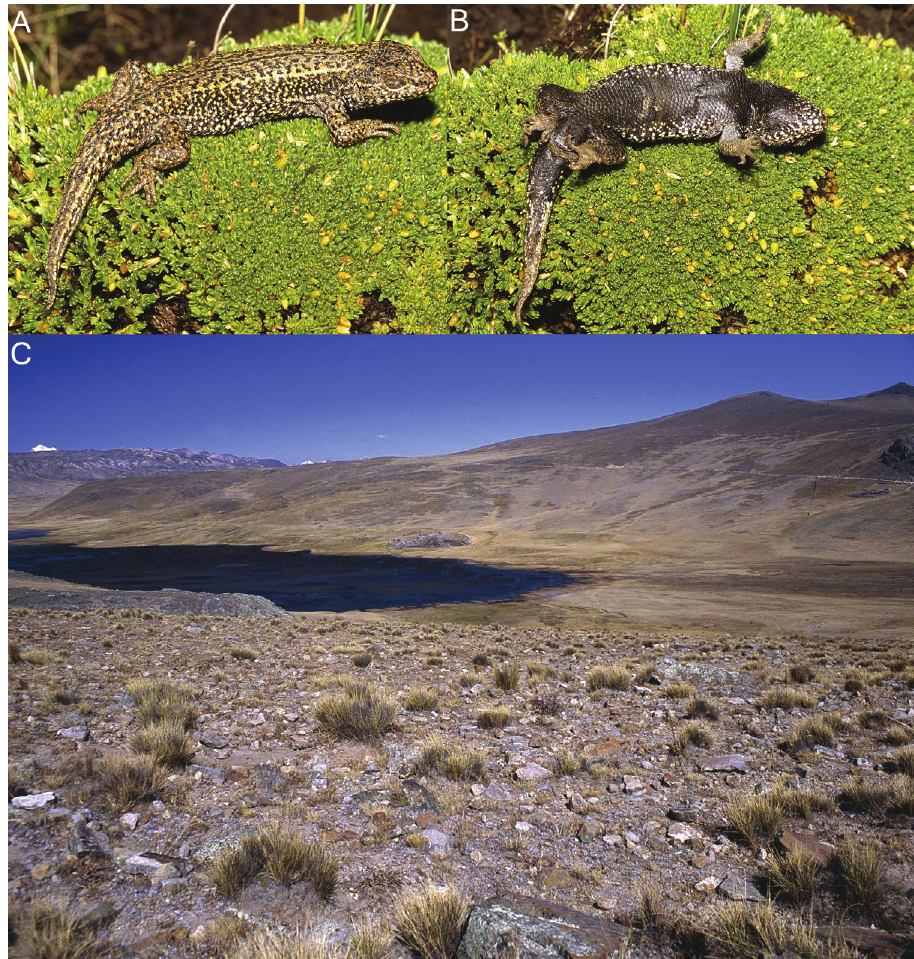
Figure 8. Dorsal ( a ) and ventral ( B ) views of the holotype of Liolaemus chavin sp. n. ( C ) Type with rostral, separated from first supralabial by one scale, nasal bordered by eight scales; canthus separated from nasal by one scale. Six supralabials. Six lorilabial scales, three in contact with the subocular. Six infralabials. Auditory meatus oval (height 2.3 mm, width 1.2 mm), with three small, projecting scales on anterior margin. Seven convex, smooth temporals. Orbit–auditory meatus distance 4.9 mm. Orbit–anterior margin of rostral distance 6.3 mm. Rostral almost three times wider than high (width 2.9 mm; height 1.2 mm). Mental subpentagonal, about two times as wide as high (width 3.2 mm; height 1.7 mm). Interparietal pentagonal with an elongated posterior apex, bordered by eight scales, the parietal slightly smaller. Frontal quadrangular. Supraorbital semicircles complete on both sides. Semicircles formed by 6 scales. Four enlarged supraoculars. Six distinctly imbricate superciliaries on both sides. Eleven upper and ten lower ciliaries.